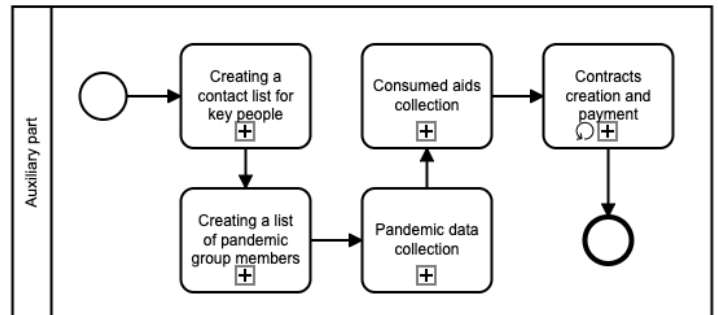
Figure 10. An auxiliary part of a pandemic plan.